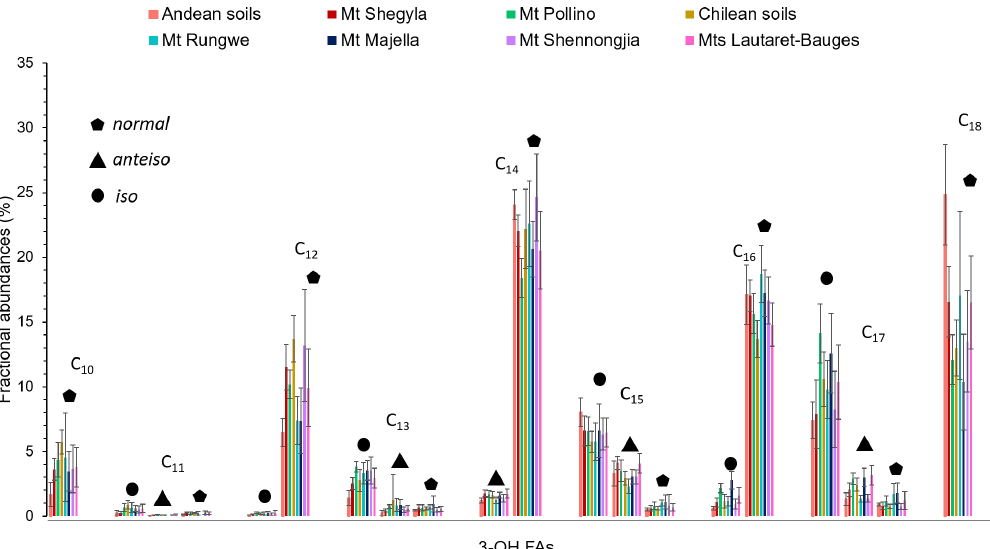
Figure 1. Average distribution of 3-OH FAs along the eight altitudinal transects investigated in this study. Data from Mt. Majella and Mt. Rungwe were taken from Huguet et al. (2019). Data from Mt. Shennongjia were taken from Wang et al. (2016). Data from Mt. Bauges and Mt. Lautaret-Galibier were taken from Véquaud et al. (2021).